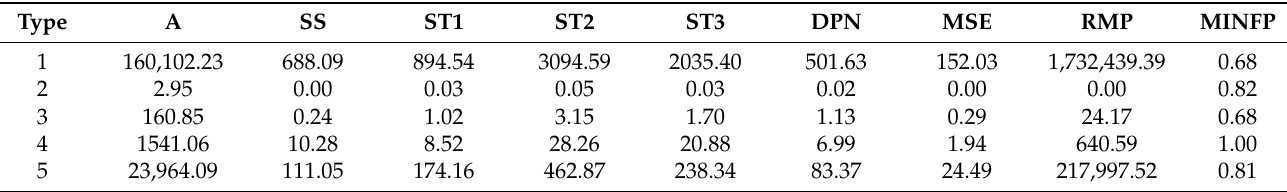
Table 4. Electricity characteristics in August.